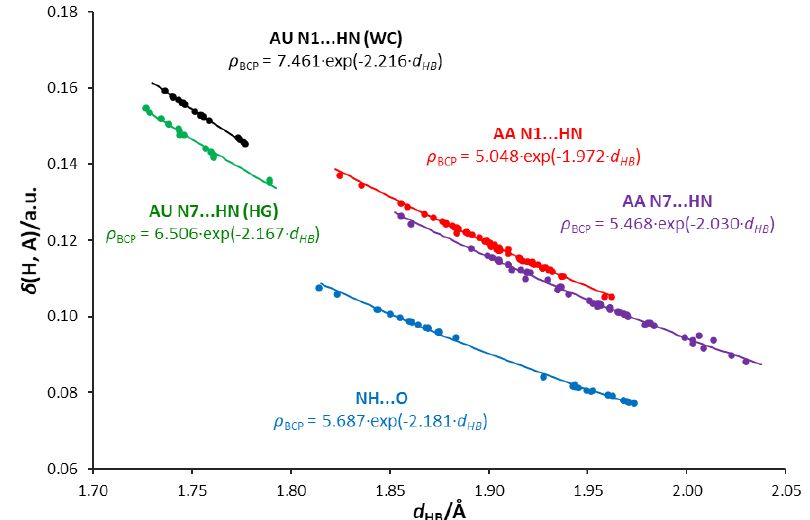
Figure 9. Dependences of the delocalization index, δ (H,A), on the H-bond lengths, d HB , in the studied adenine-uracil and adenine-adenine base pairs.